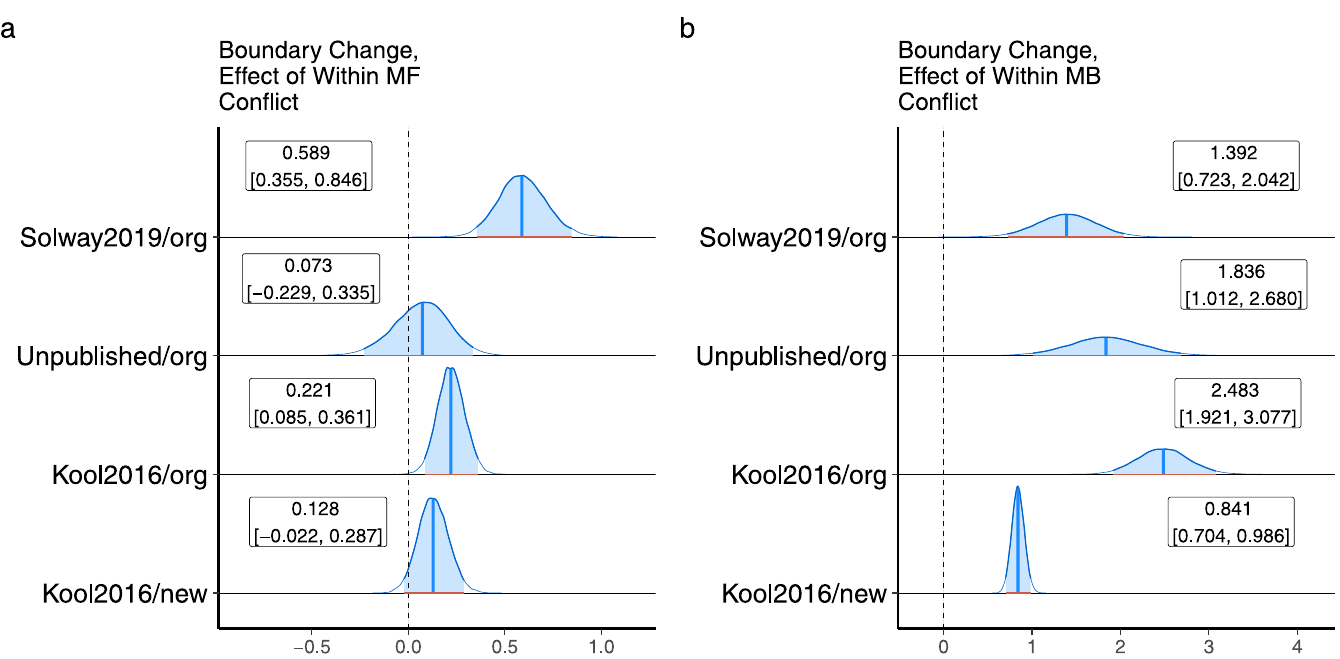
Fig 7. A. The effect of within-system model-free conflict (Q-value differences) on decision boundary separation. B. The effect of within-system model-based conflict on decision boundary separation.